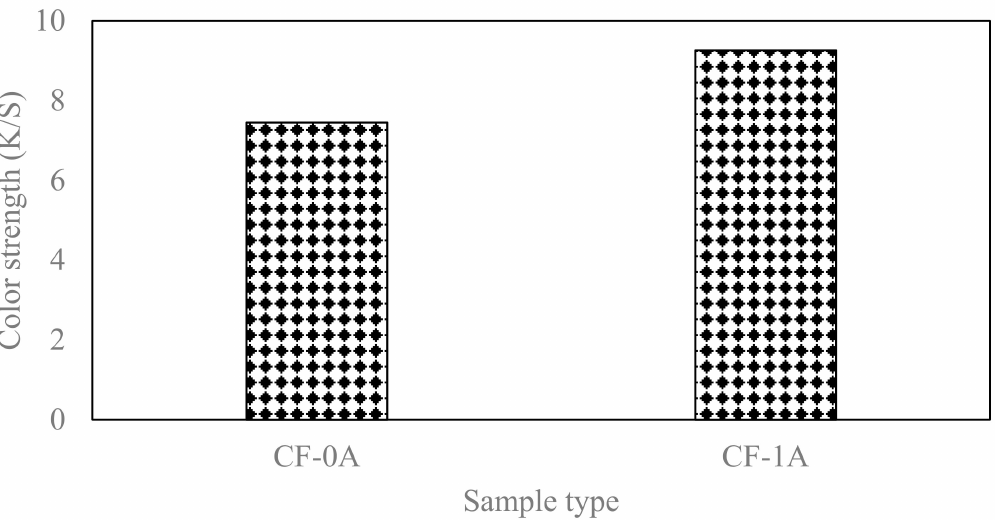
Figure 5. Color strength of the dyed fabrics.